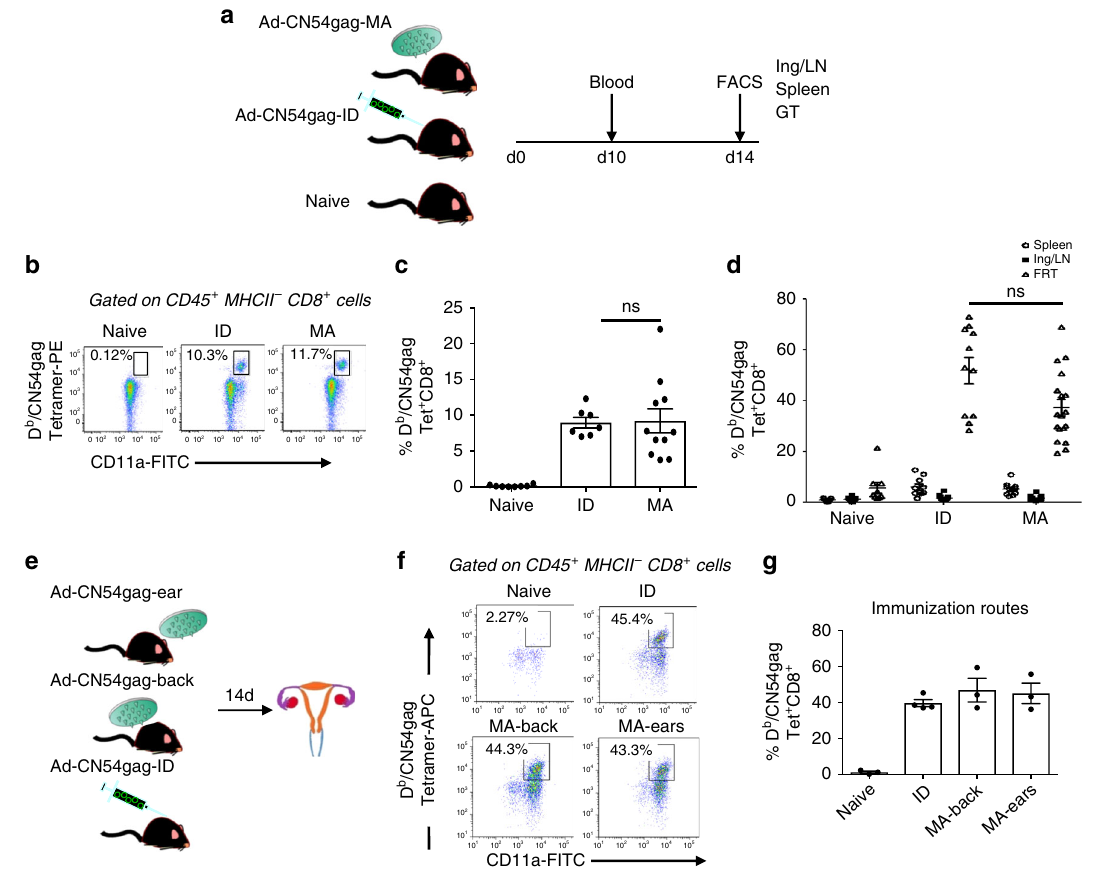
Fig. 1 Skin immunisation irrespective of anatomic site recruits CD8 + T cells to the FRT. a Experimental design. b – d Flow-cytometry plots and graphs showing frequencies of CD8 + D b /CN54gag tet + cells in blood (day 10) and indicated tissues (spleen, inguinal LN and FRT) on day 14 after ID or MA (back skin) immunisation with Ad-CN54gag. Data are from four independent experiments ( n = 7 – 18 mice per group). e Experimental design. Mice were immunised by MA either to the dorsal surface of the ear or to back skin or ID. f , g Flow-cytometry plots and graph showing frequencies of CD8 + D b / CN54gag Tetramer + cells in FRT (day 14). Data are representative of two independent experiments ( n = 3 – 4 mice /group). d , g p >0.05 (ns) by one-way ANOVA, error bars show